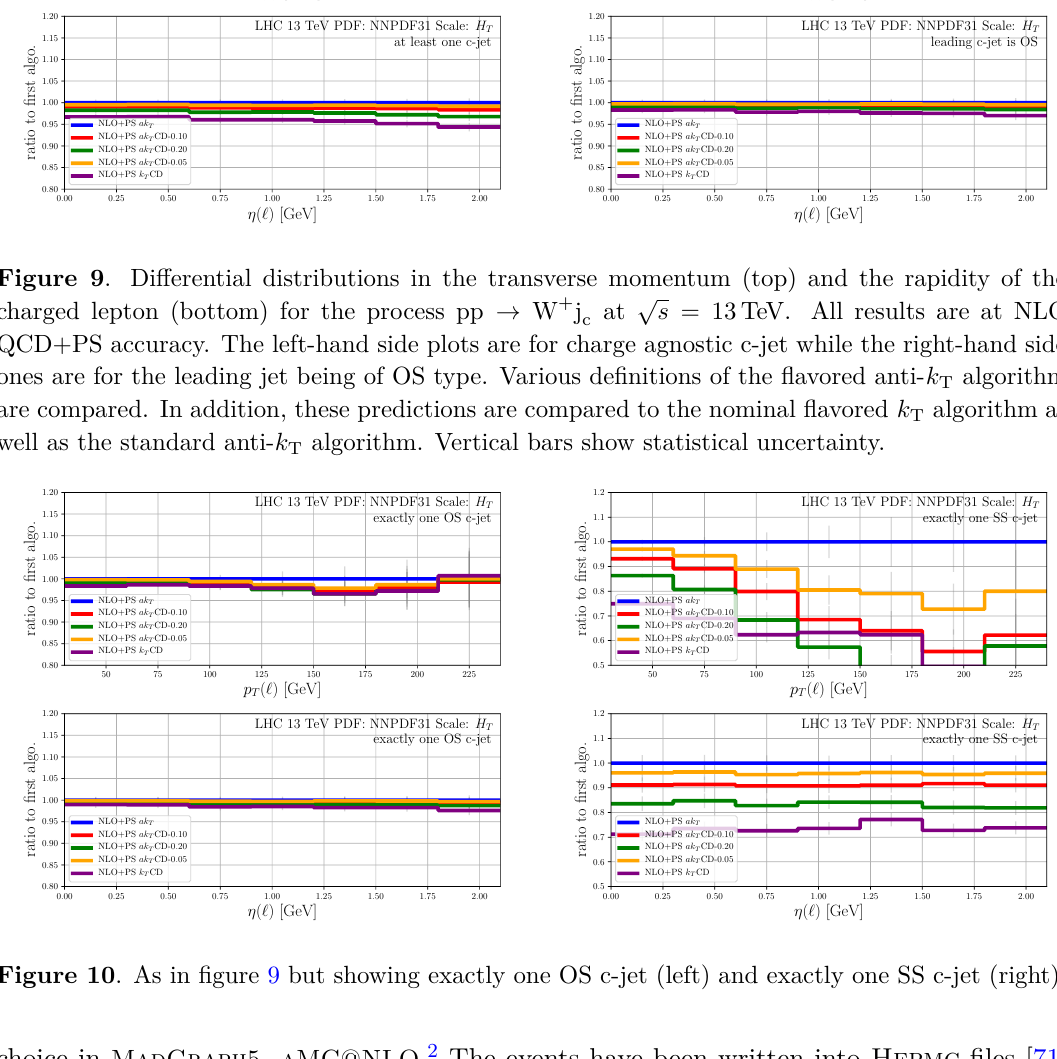
choice in MadGraph5_aMC@NLO . 2 The events have been written into Hepmc files [71] and are analysed using the Rivet analysis framework